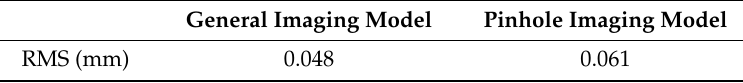
Table 3. Error valuation of general imaging model and pinhole imaging